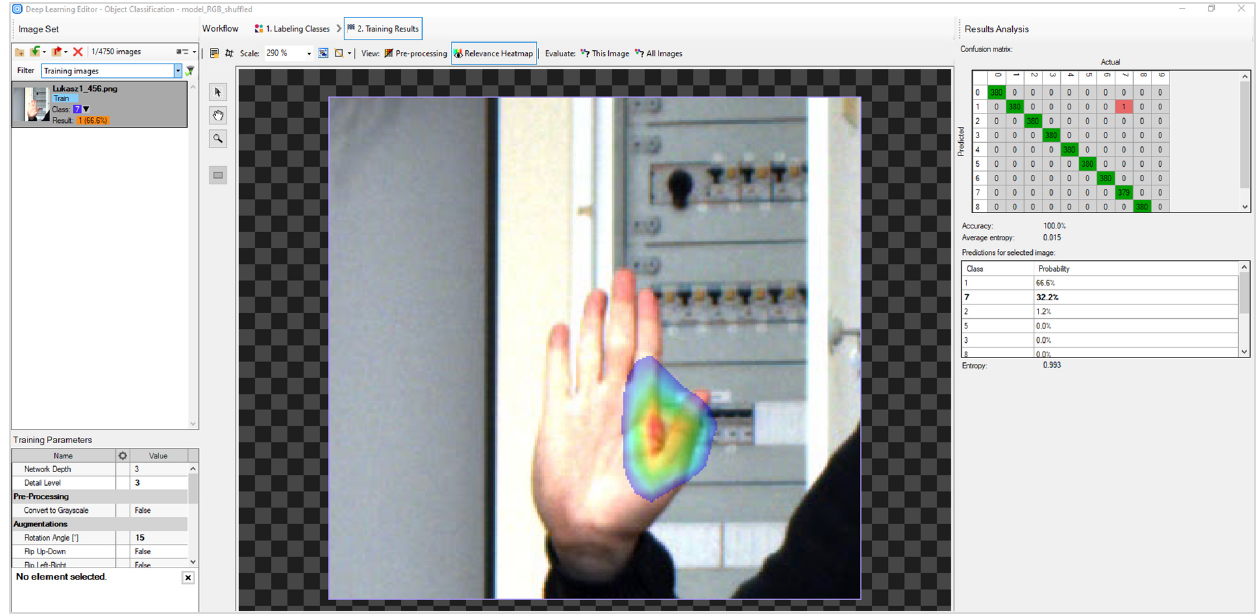
Figure 10. Deep Learning Editor interface in AVS.